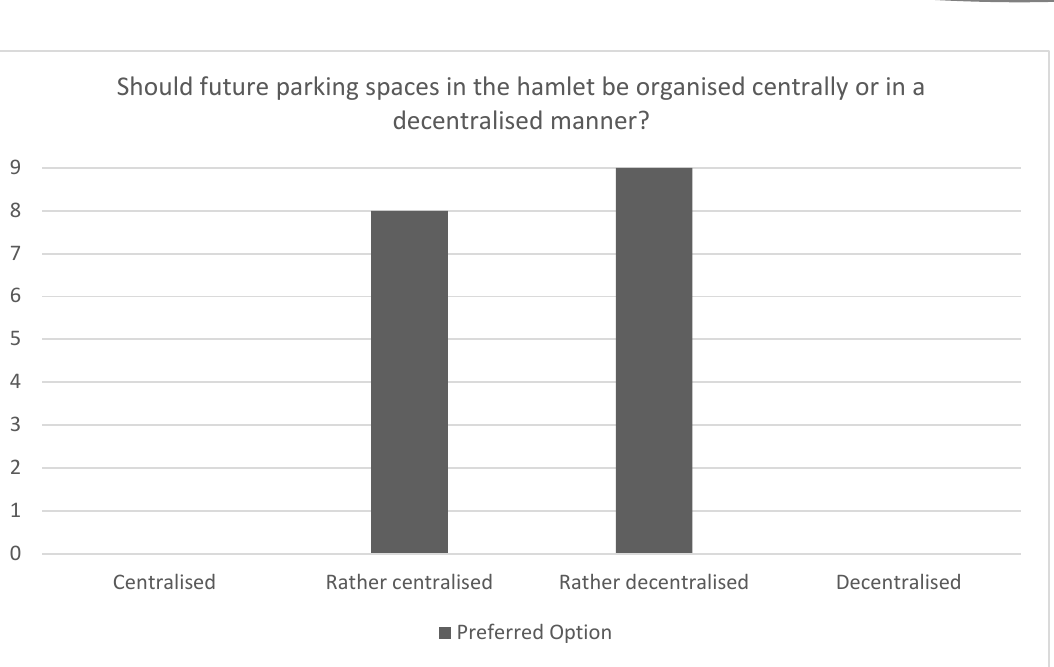
Figure 20: Results of the question on centralised versus decentralised parking solutions The question of whether future parking spaces in the hamlet should be organised centrally, or in a decentralised manner was rather contested, with 8 out of 17 favouring a “rather centralised” solution, and 9 out 17 favouring a “rather decentralised” solution.